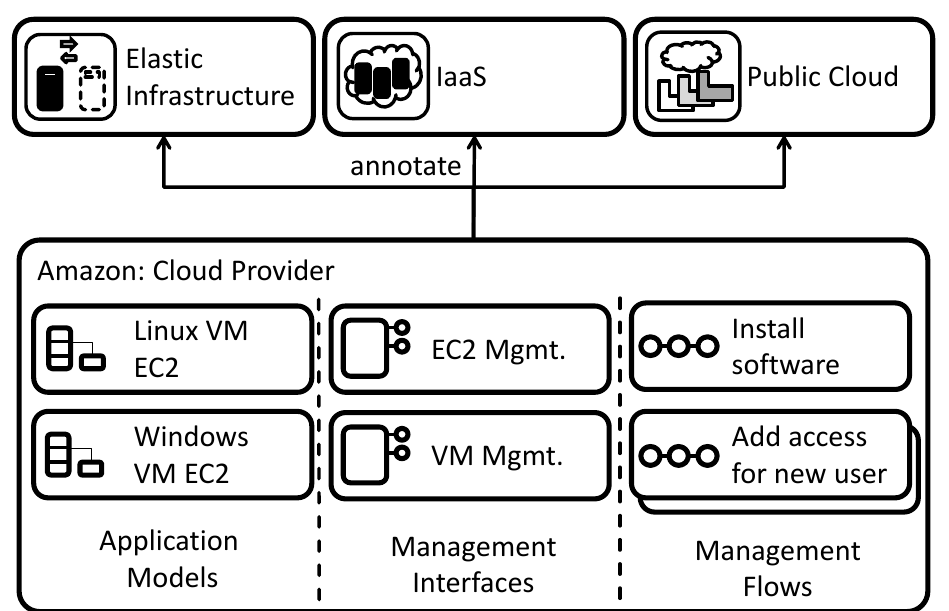
Figure 16. Implementations Artifacts of Amazon